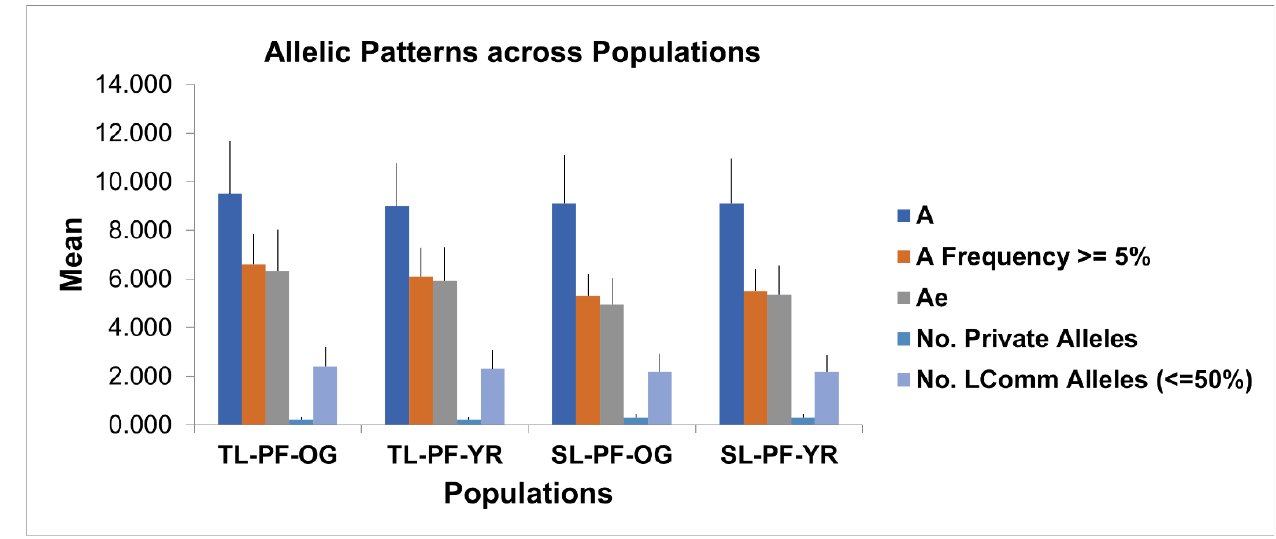
Figure 2. Allele patterns across the white spruce populations. A, number of alleles per locus; A Frequency >= 5%, number of alleles per locus with frequency of ≥ 0.05 (5%); Ae, effective number of alleles per locus; No. Private Alleles, total number of private alleles (A P ); No. LComm Alleles (<=50%) = number of locally common alleles (Freq. <= 5%) found in 50% or fewer populations.